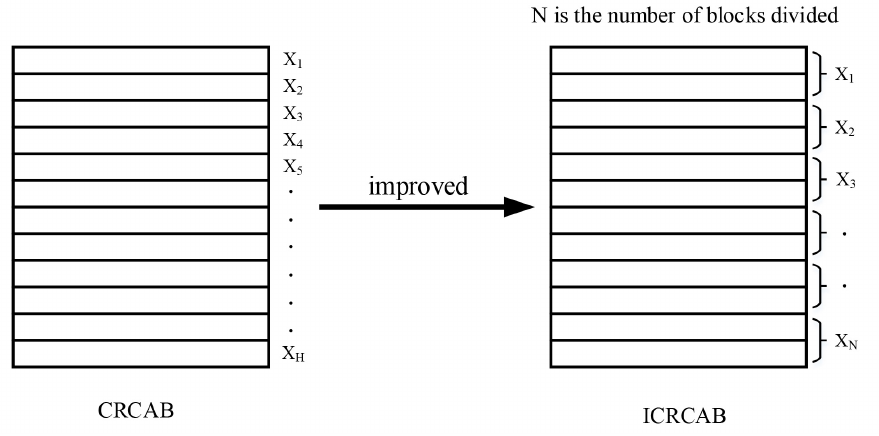
Figure 7. The feature row vectors in CRCAB ( left ) and ICRCAB ( right